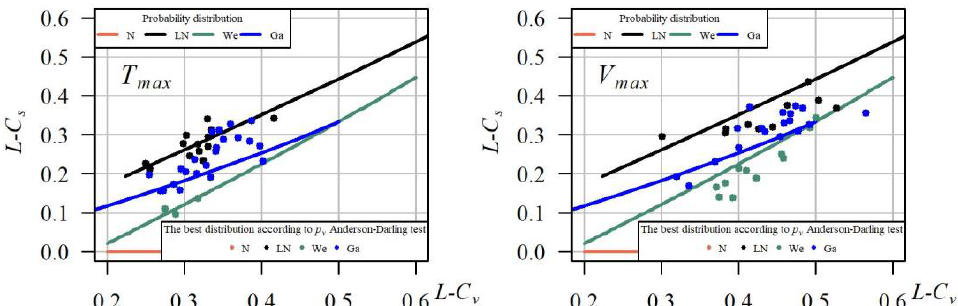
Figure 10. Dependence of the linear coefficient of skewness L- C s on the linear coefficient of variation L - C v for four tested probability distributions (N – normal, LN – lognormal, We – Weibull, Ga – gamma) of the duration T max and volume V max of the maximum droughts, in 40 cross-sections.